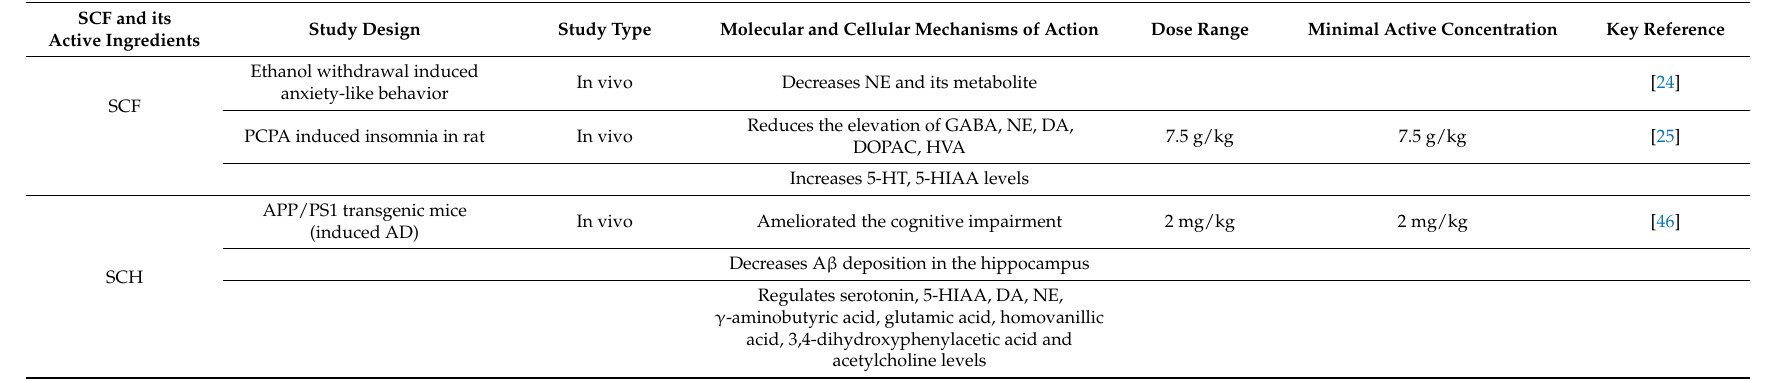
Table 5. The pharmacological data of SCF and its active ingredients in protecting against NDs by regulating neurotransmitters. PCPA—4-chloro-dl-phenylalanine; GABA—gamma-aminobutyric acid; DA—dopamine.